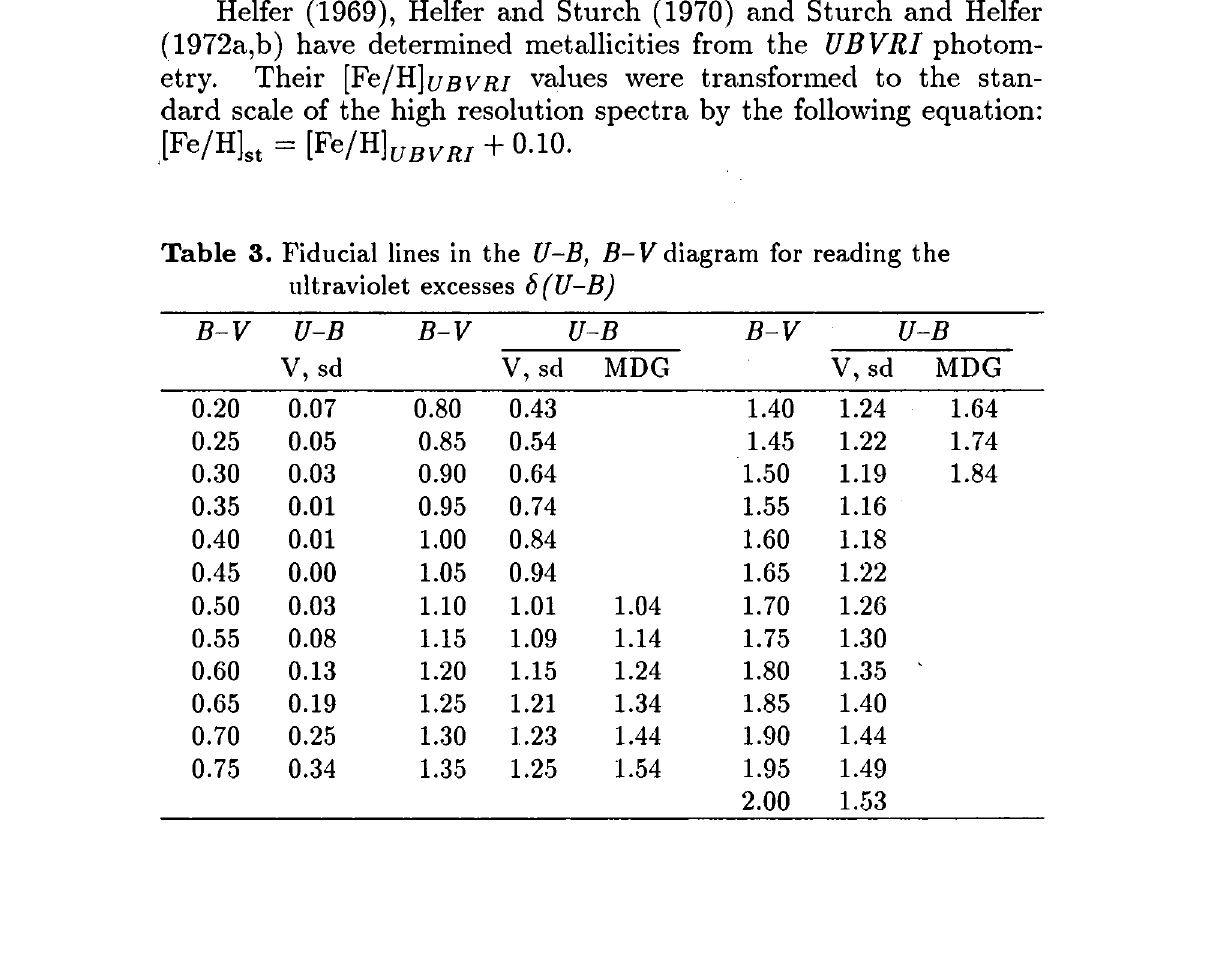
Table 3. Fiducial lines in the U-B, B-V diagram for reading